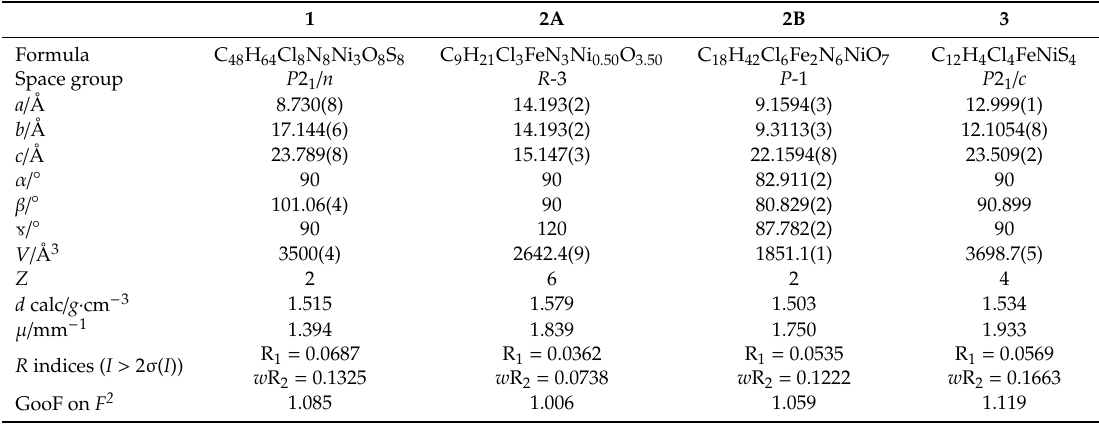
Table 1. Crystal and refinement data for compounds 1 , 2A , 2B , and 3 .